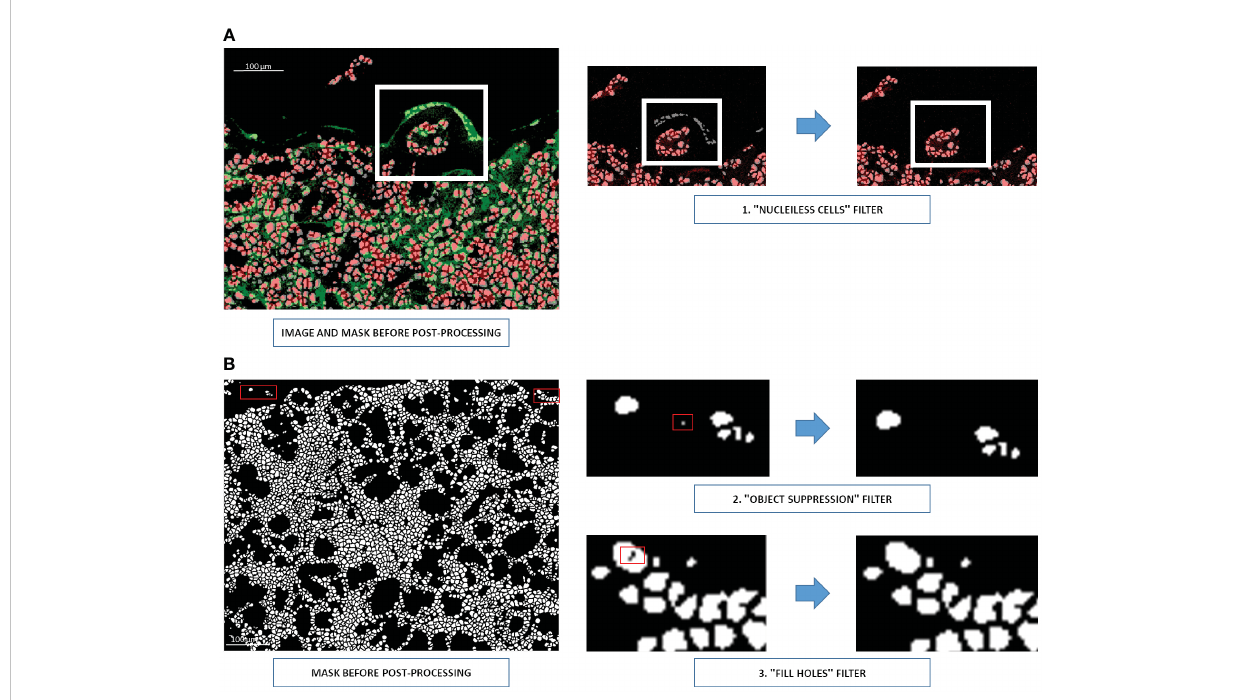
FIGURE 5 Three post-processing steps for U-Net output (A) Elimination of cells without nuclei signals (step 1). Nuclei are shown in red and membranes in green. A white rectangle indicates the region requiring corrections. (B) Removing one- or two-pixel objects (step 2) and fi lling holed nuclei (step 3). Cells are shown in white, and the background is shown in black. Red rectangles indicate the pixels requiring